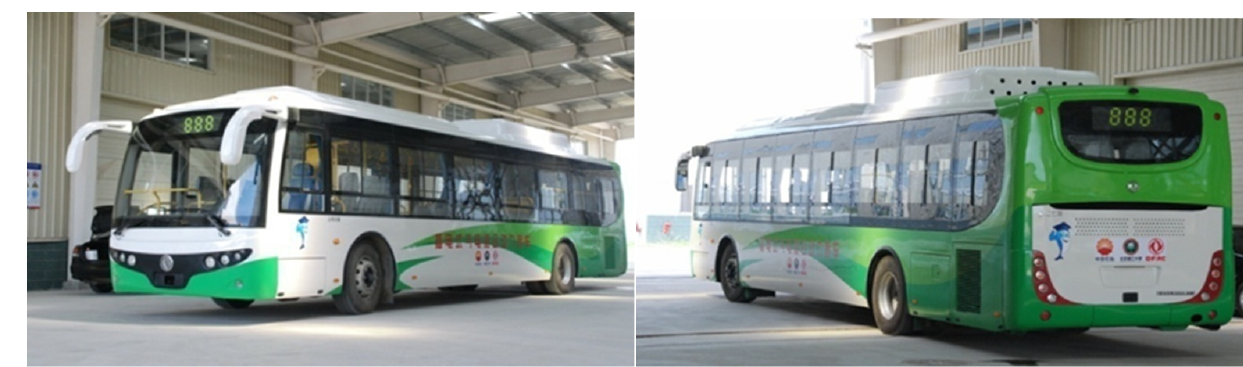
Figure 15. Typical Chinese urban driving cycle.